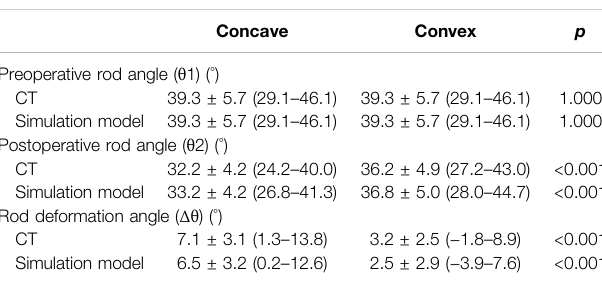
TABLE 8 | Implant-rod angle of